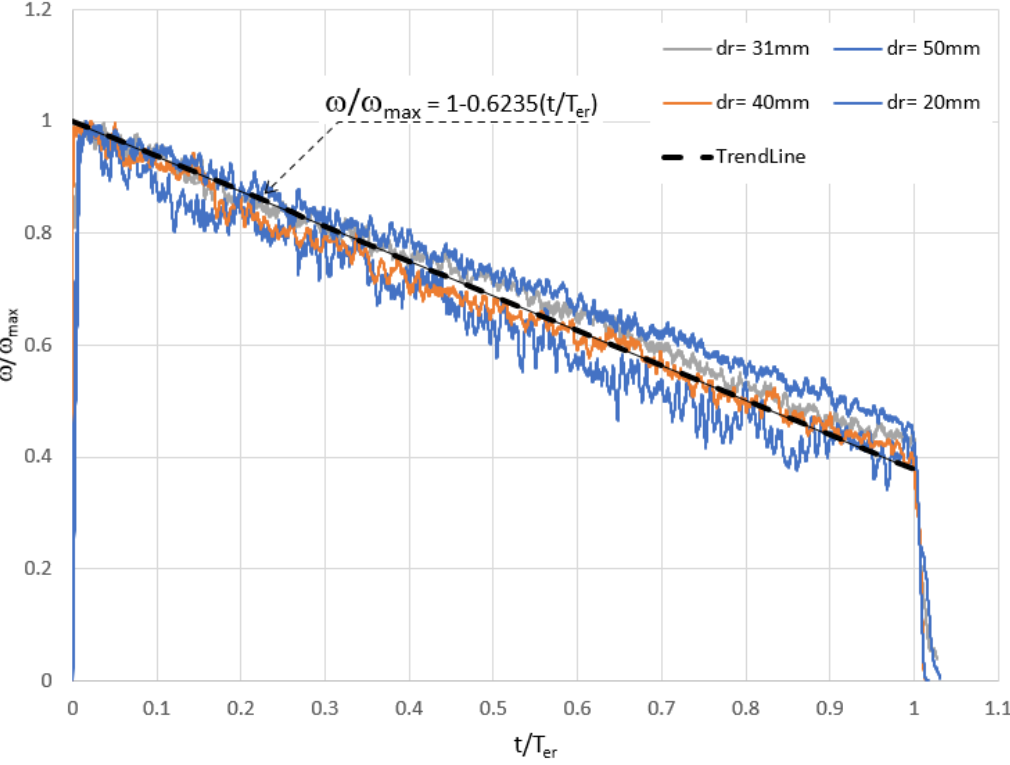
Figure 13. Temporal variation of the normalized rotor’s angular speed (4-blade rotors).